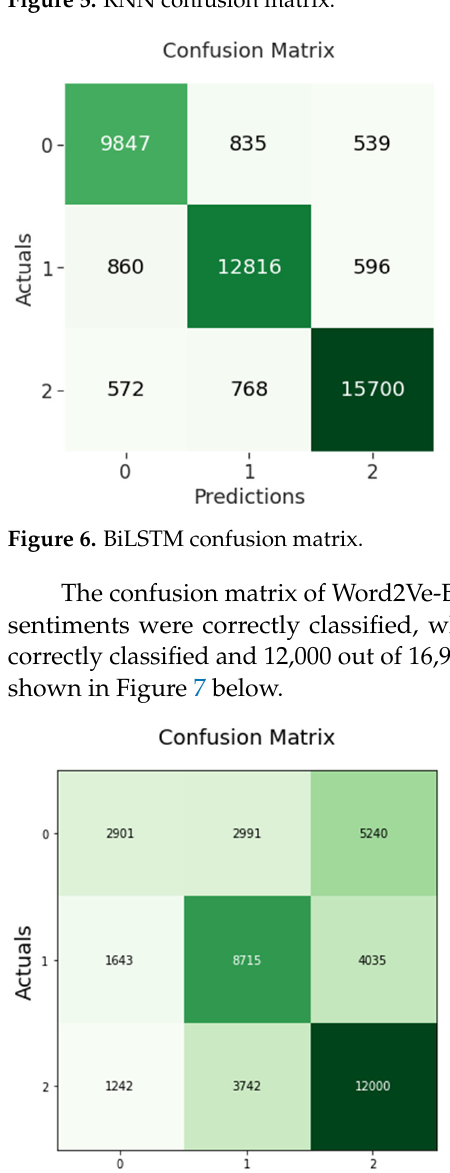
Figure 5. RNN confusion matrix.